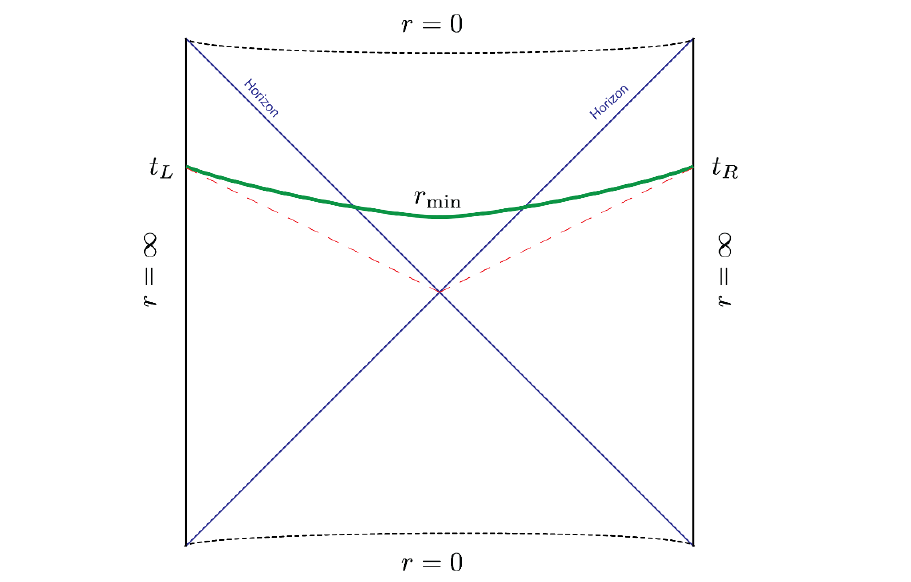
Figure 5 . A representation of the maximal wormhole connecting the two boundaries anchored at times t L and t R (depicted at symmetric times in the (cid:12)gure). The bridge reaches the minimum distance inside the future horizon at r min , and approaches each boundary tangent to constant time